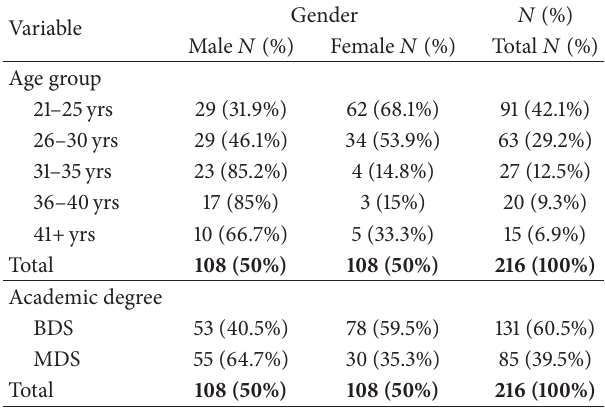
Table 1: Description of the respondents based on gender and academic